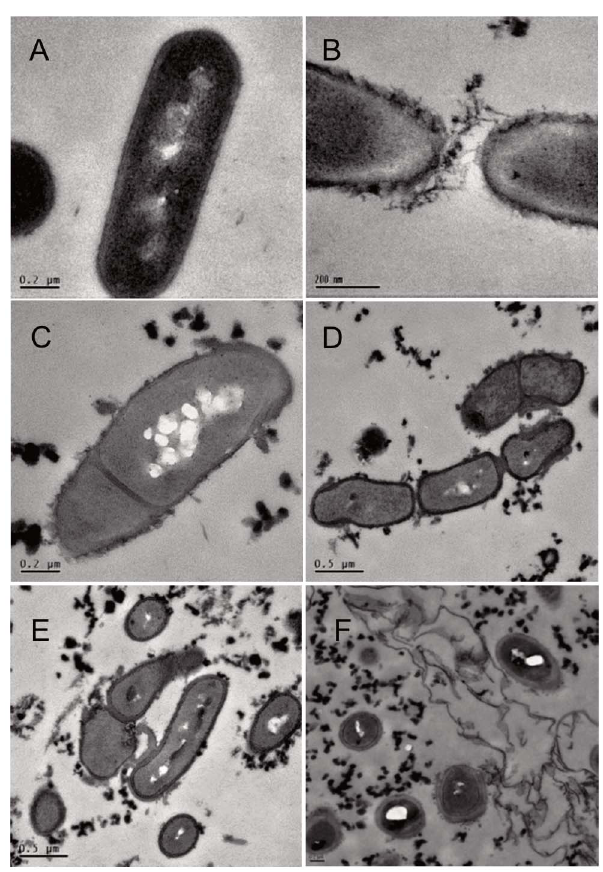
Figure 2. Transmission electron micrographs of lag phase-cells of L.plantarum WCFS1 treated with tannic acid . Cells were grown for: 4 h in RPM medium lacking tannic acid (A); 16 h (B, C, D, E, F) in RPM medium containing 0.5 mM tannic acid. Scale bar 0.2 m m (A, B, C, F); 0.5 m m (D, E).